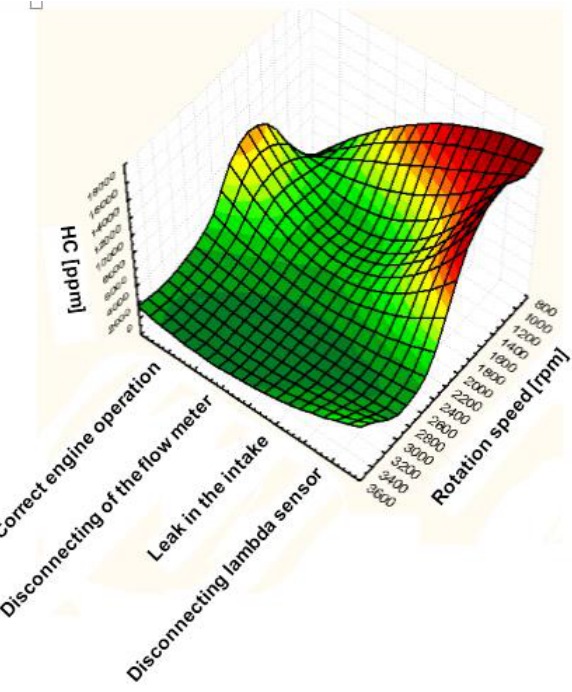
Fig. 18. The hydrocarbon content as a function of rotational speed for an efficient engine and simulated damage – an engine fueled with